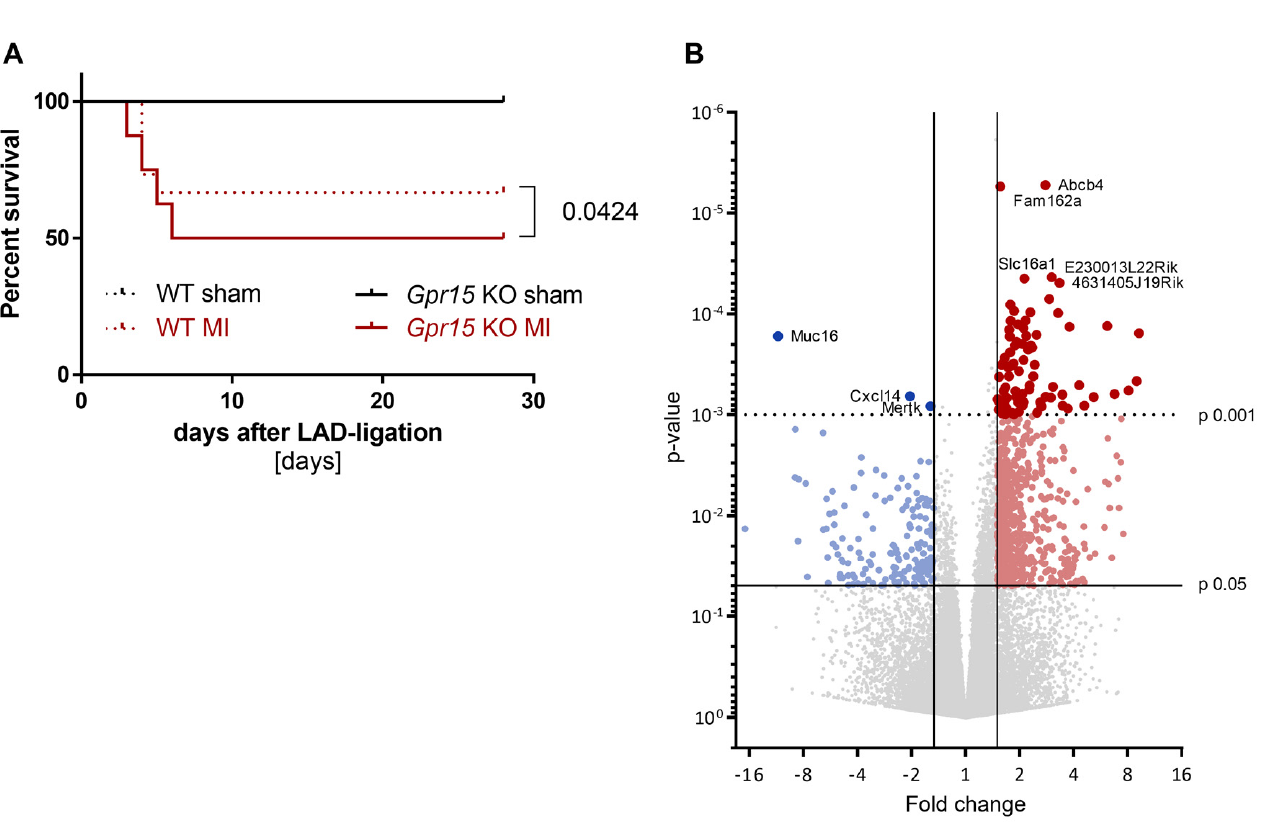
Figure 5. Reduced survival and differential gene expression in Gpr15 gfp/gfp mice after induced myocardial infarction. ( A ) Survival was slightly lower in Gpr15 gfp/gfp mice compared to wildtype mice ( p = 0.0424, n = 5/6 sham and 15/16 MI). log-rank test ( B ) Gene expression measured by 3 ′ mRNA sequencing of cardiac tissue from the IZ from nine Bl6 wildtype (WT) and eight Gpr15 gfp/gfp mice 5 days after MI surgery. Downregulated genes in cardiac tissue from Gpr15 gfp/gfp compared to WT mice are depicted in blue, while red highlights upregulated genes. Fold change and p -value are displayed in the volcano plot to identify significant differences in gene expression. Further restricted by p -value ≤ 0.001, 84 top differentially expressed genes were identified (81 upregulated and three downregulated genes). Gene symbols for five upregulated genes with the lowest p -value and for the downregulated genes are displayed. Red and blue colors highlight significantly regulated genes with p -value < 0.05 (small dots) or p -value < 0.001 (large dots).